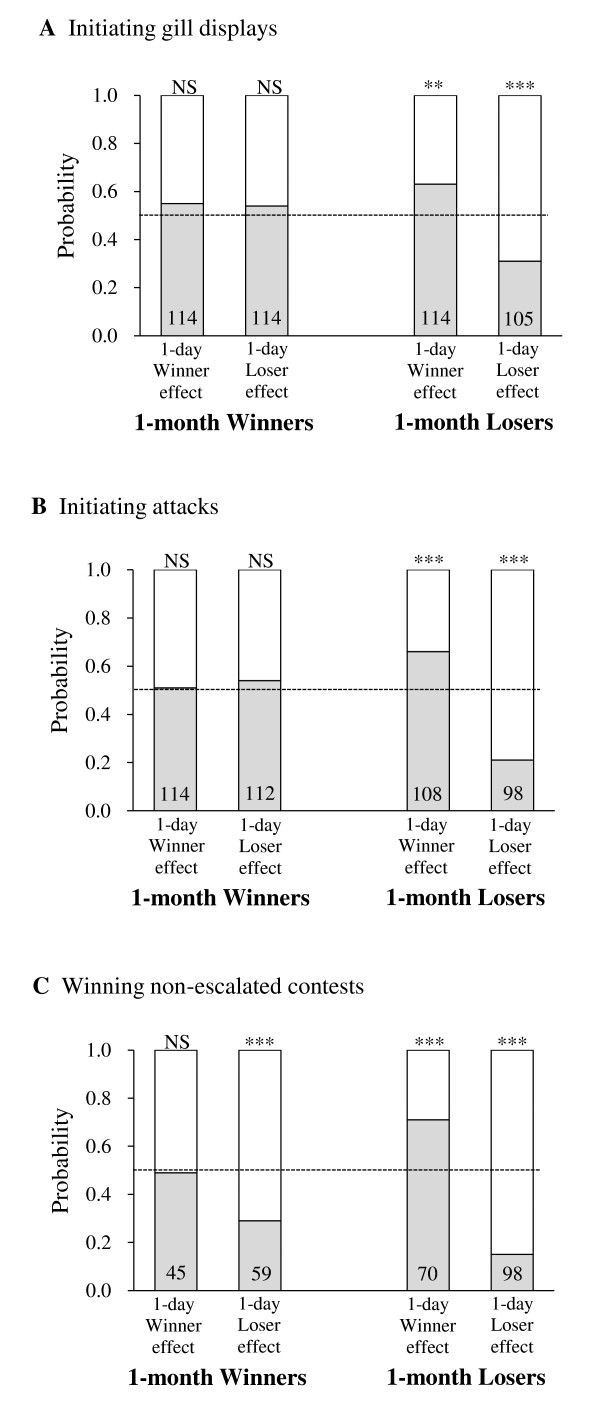
Influence of 1-month winning/losing experience on the importance of 1-day winning/losing experience. The importance of the 1-day winning (winner effect) or losing (loser effect) experience on the probability of (A) initiating gill displays, (B) initiating attacks and (C) winning non-escalated contests when both individuals of a contest pair were subjected to either winning or losing experience treatment one month prior to Test Day. The shaded portion of the bars represents the probability that the focal individual would carry out the relevant behavior (initiate displays, initiate attacks or win non-escalated contests) and the clear portion shows the probability for its control opponent. (The focal individual is the contestant that received a winning or a losing experience one day prior to Test Day; its control opponent is the animal that received no experience one day prior to Test Day.) NS P > 0.05; * P ≤ 0.05; ** P ≤ 0.01; *** P ≤ 0.001; binomial test for whether the behavior concerned showed a significant winner or loser effect for the 1-month dominant or subordinate experience. The sample size for each bar is presented on the bottom of the bar. (Sample sizes differ because not all contests involved all behaviors).